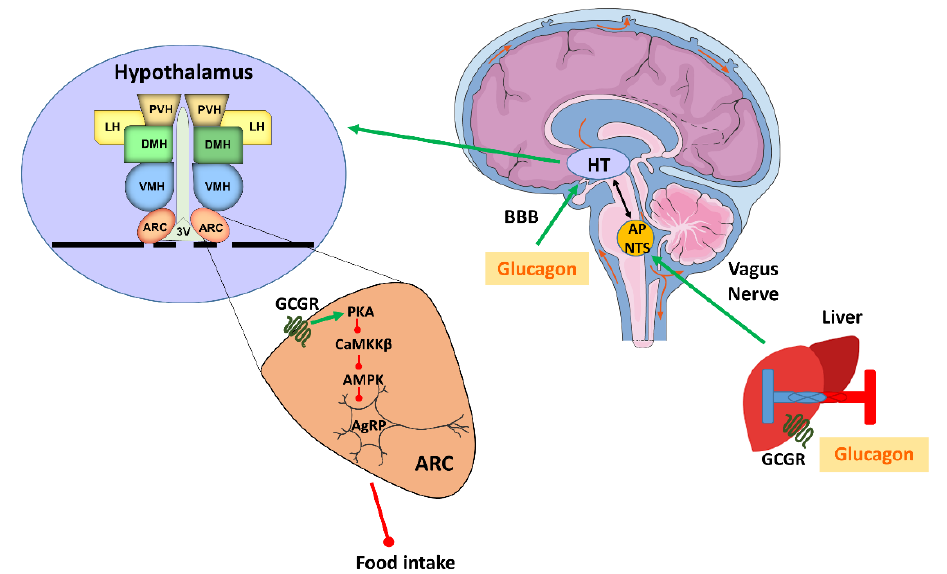
Figure 1. Glucagon control on food intake. Diagram of the neuronal pathway that regulates the anorexigenic action of glucagon. Green arrows indicate an increase or activation, while red arrows indicate a decrease or inhibition. AgRP: Agouti related peptide; AMPK: Adenosine monophosphate -activated protein kinase; AP: Area Postrema; ARC: Hypothalamic arcuate nucleus; BBB: Blood brain barrier; CaMKK β : Ca2 +/ calmodulin-dependent protein kinase kinase β ; DMH: Dorsomedial hypothalamic nucleus; GCGR: Glucagon receptor; HT: Hypothalamus; LH: Lateral hypothalamic